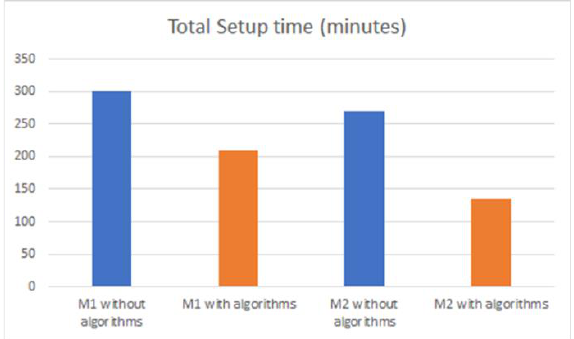
Figure 11. The performance of the total setup times for each machine.